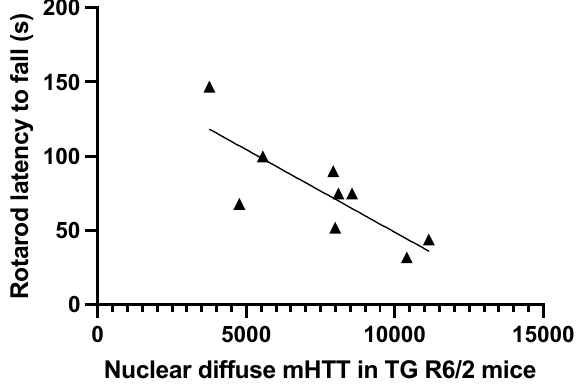
Figure 7. Correlation between rotarod and diffuse mHTT in R6/2 mice treated with GLYN122. Pearson r: − 0.8, p = 0.01, n = 9 (all transgenic female mice), confidence interval of r = − 0.9561 to − 0.2896 for nuclear diffuse mHTT. TG, transgenic R6/2 mice; mHTT mutated